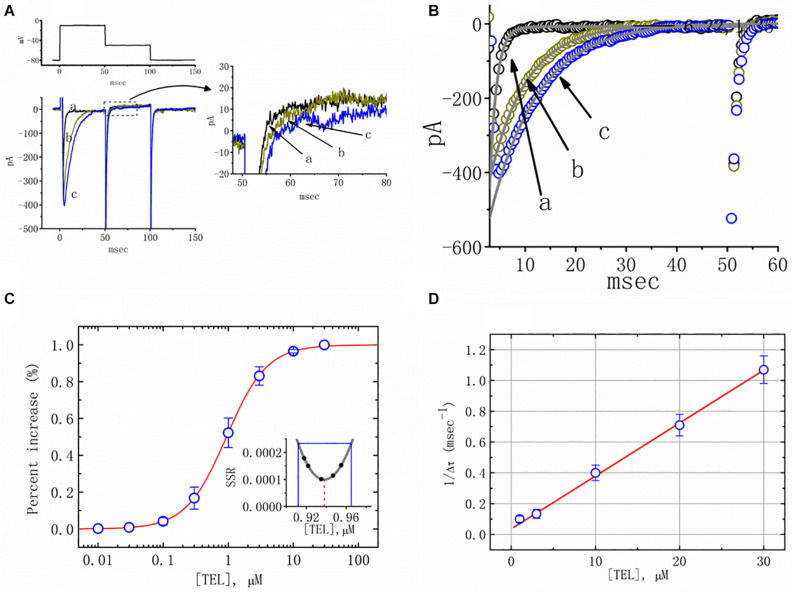
Effects of telmisartan (TEL) on voltage-gated Na+ current (INa) in mHippoE-14 neurons. In these experiments, cells were suspended in Ca2+-free Tyrode’s solution containing 0.5 mM CdCl2 and 10 μM TEA. A pipette was filled with a Cs+-containing solution. (A) Original INa traces attained in the control (a) and in the presence of 1 μM (b) and 3 μM (c) TEL. The voltage pulses indicated in the upper part of (A) were depolarized from −80 to −10 mV and stepped back to −50 mV, at which point, tail currents were measured (right part). The right part of (A) indicates expanded records of tail currents, which correspond to the traces shown in the dashed box. (B) Perturbating effects of TEL on inactivation time course of INa. Current trajectory for the inactivation time courses of INa in the absence or presence of TEL was well fitted by one- or two-exponential functions, respectively. a: control; b: 1 μM TEL; c: 3 μM TEL. (C) Concentration-dependent effect of TEL on the percentage increase in peak INa (mean ± SEM; n = 9-13 for each point). The smooth red line in (C) represents the best fit to a modified Hill equation (Equation 1). The EC50 value and Hill coefficients for TEL-induced stimulation of INa were 0.94 mM and 1.4, respectively. The inset in (C) shows the confidence assessment of the best-fit parameter values (i.e., EC50). The parameter range corresponds to an approximate 95% confidence interval. The blue line marks the parameter value at which SSR equals 0.000234, and the broken red line is clearly pointed at the EC50 value. (D) Evaluation of the kinetics of TEL-induced effects on the inactivation time course of INa. The reciprocal of Dt was plotted against the TEL concentration (explained in Equations 3 and 4). Forward (k+1) or backward (k–1) rate constants, given by the slope and the y-axis intercept of the interpolated line, were found to be 0.0344 ms–1 μM–1 and 0.0368 ms–1, respectively. Each point is the mean ± SEM (n = 9–12).